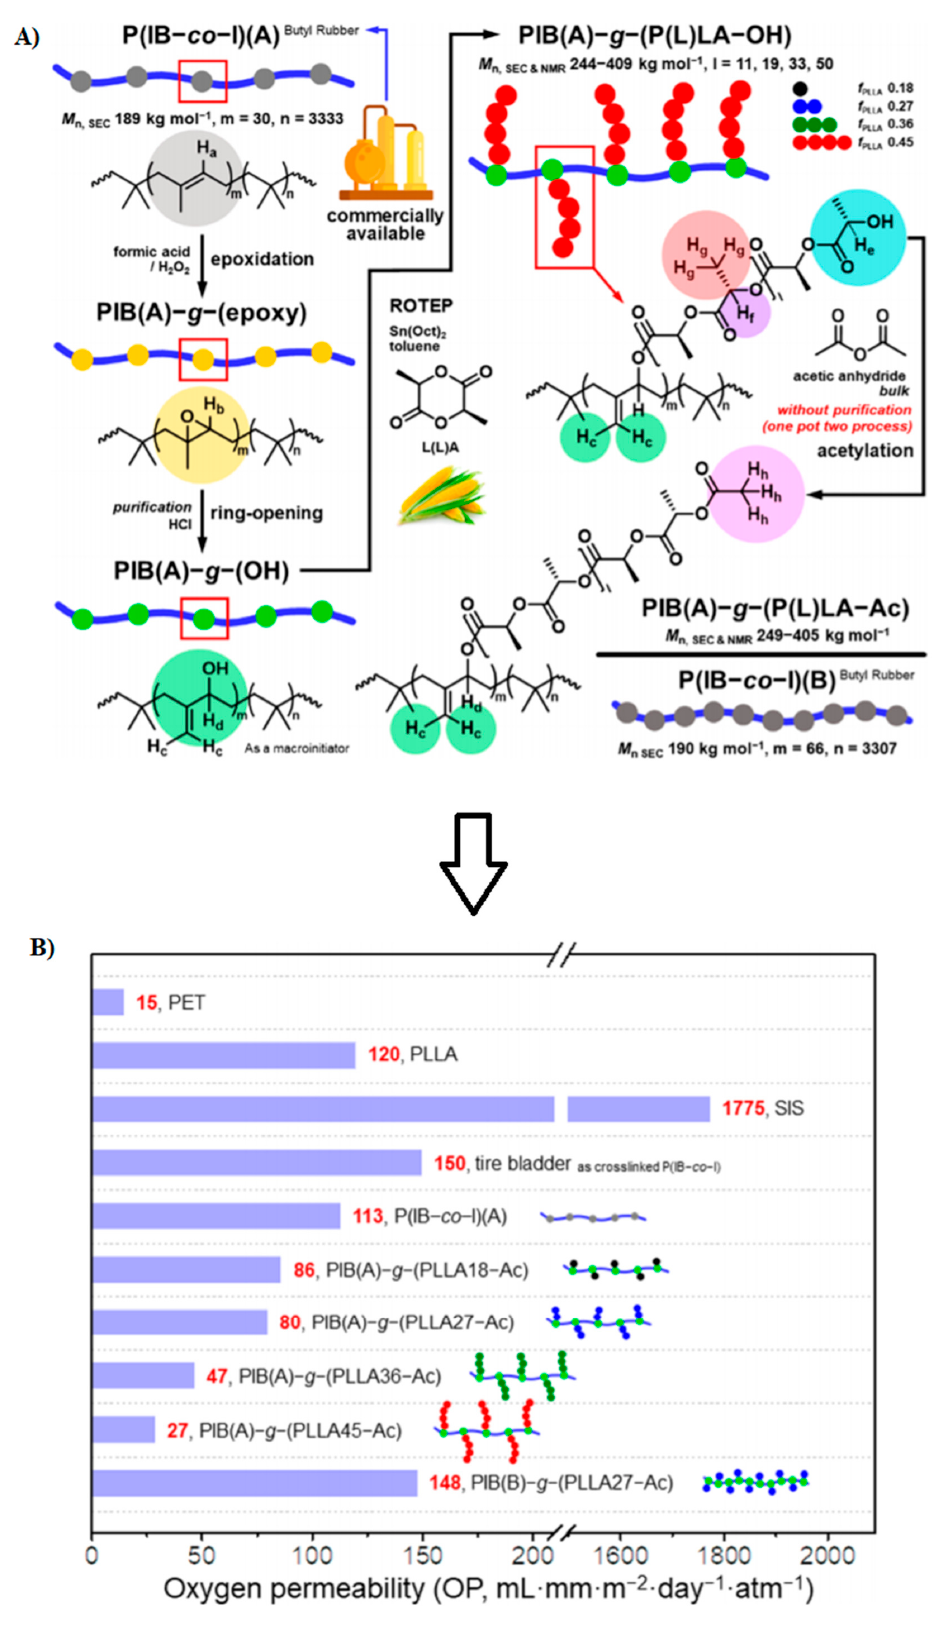
Figure 16. ( A ) Schematic synthesis of semicrystalline or amorphous poly(isobutylene)-graft- acetylated poly(lactide) (PIB-g-(P(L)LA − Ac)). ( B ) Comparison of oxygen permeability values be- tween the newly synthesized polymers and common ones. Adapted from [274] with permission from American Chemical Society. Copyright ©